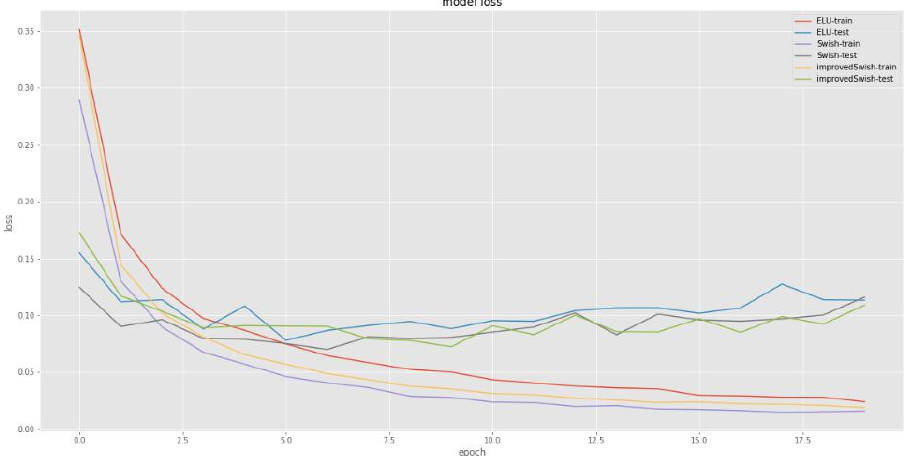
Figure 3. Comparison of loss. The horizontal axis represents epoch times (0~17.5), and the vertical axis represents loss value (0~0.35).